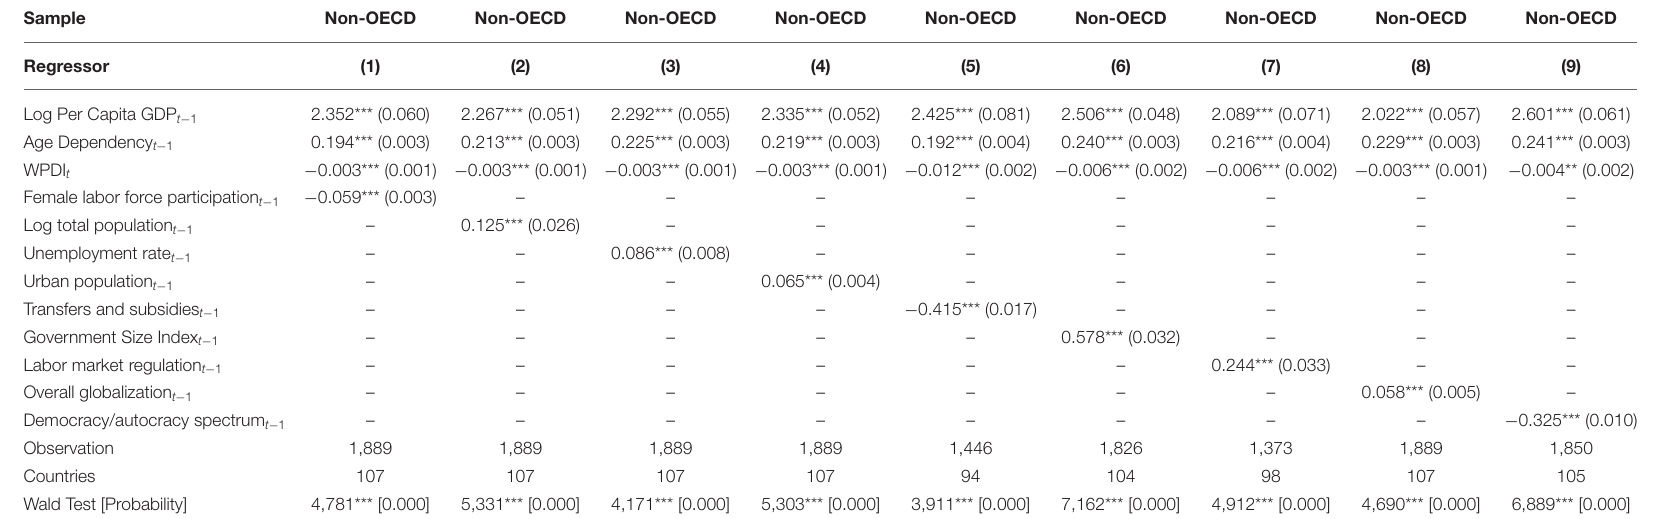
TABLE 5 | Feasible General Least Squares (FGLS) estimations (non-OECD countries)